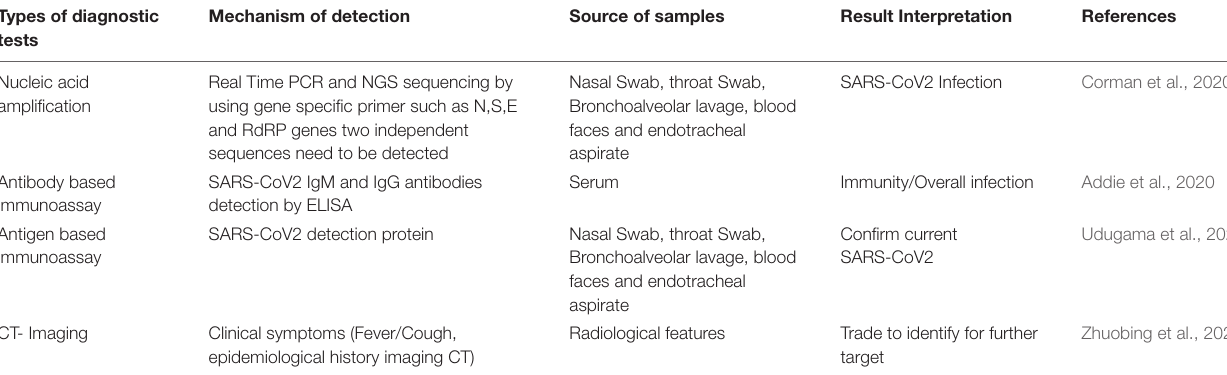
TABLE 1 | Types of diagnostic approaches in SARS-CoV-2.